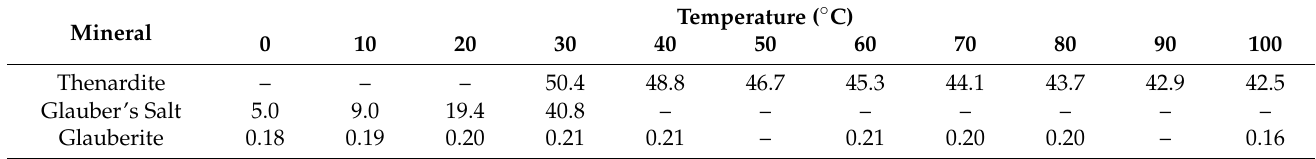
Table 7. Seven groups of obtained InSAR-CTPIM parameters [28,40].